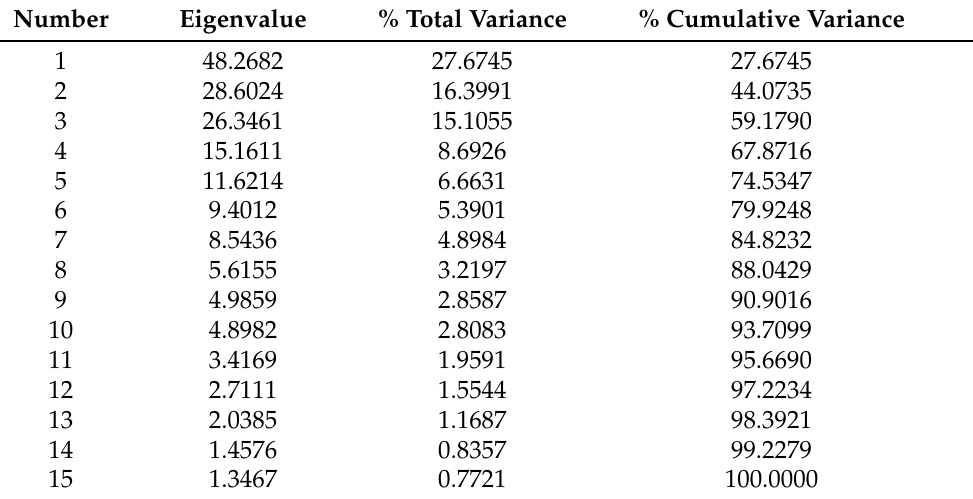
Table 3. Eigenvalues and related